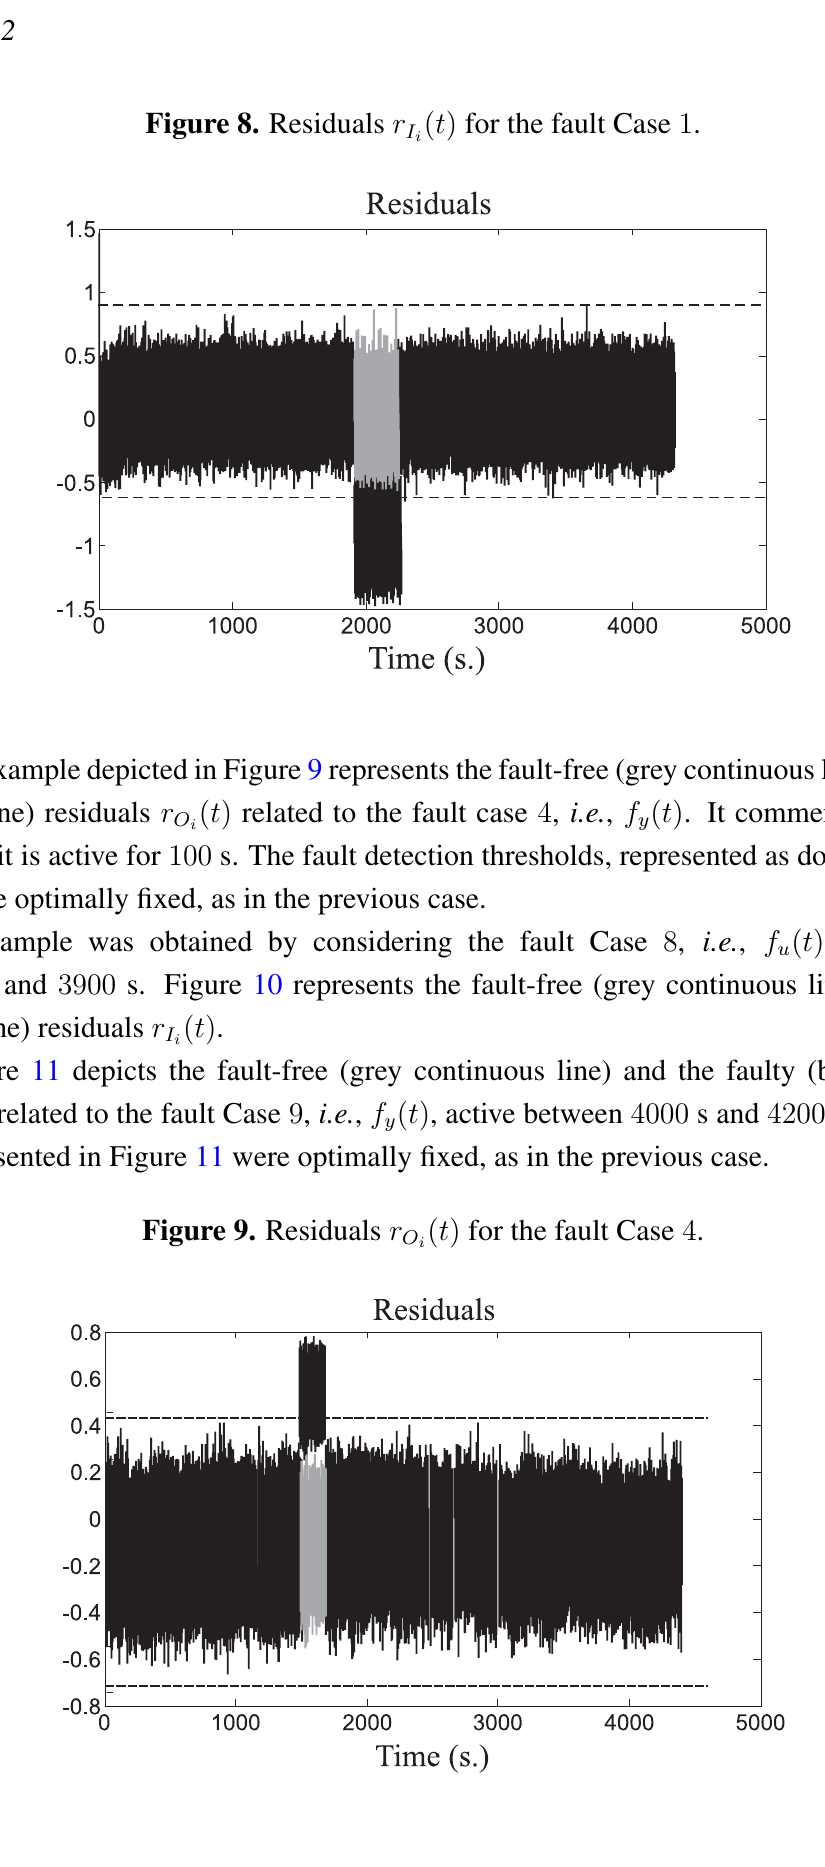
Figure 8. Residuals r